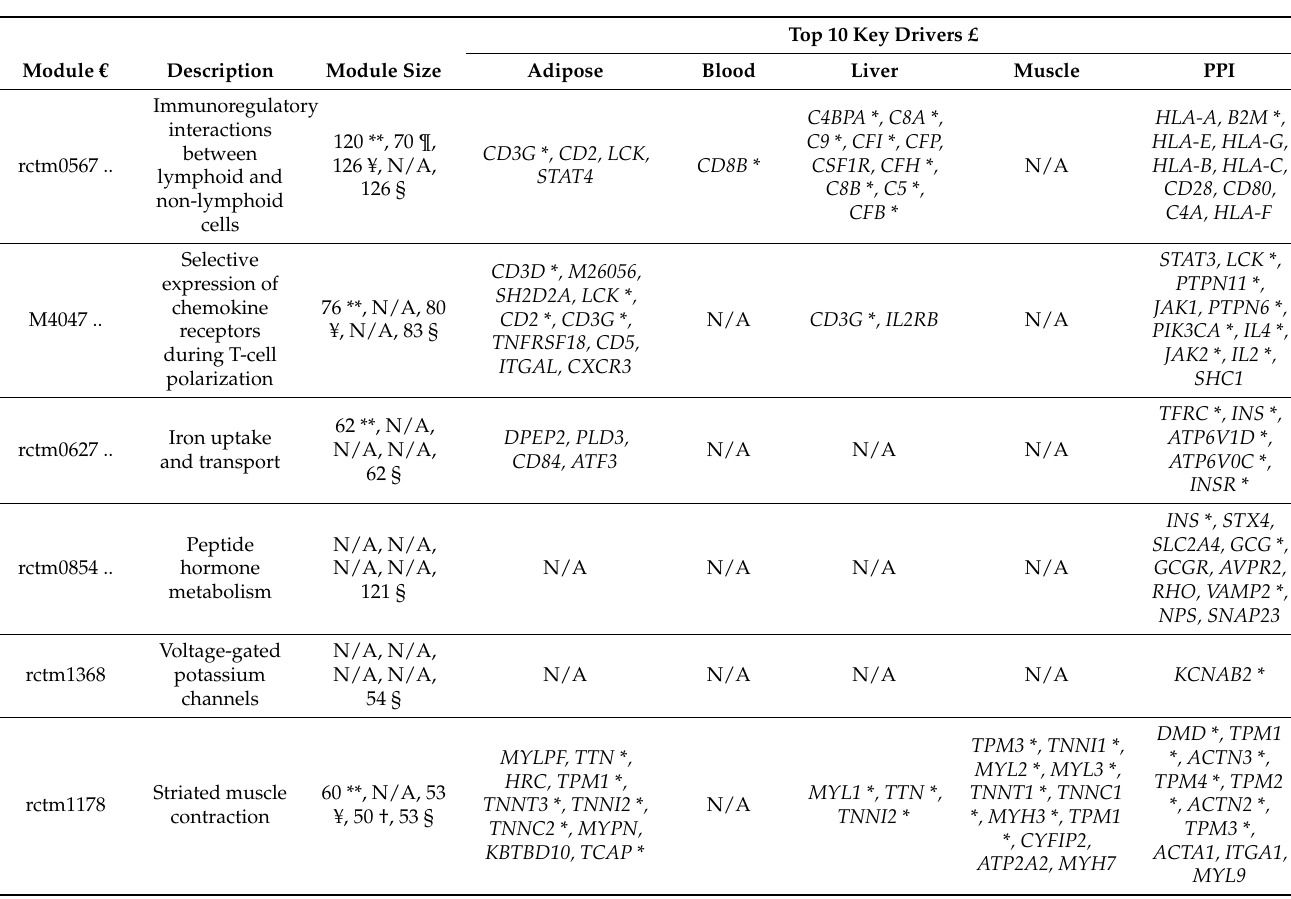
Table 1. MSEA Meta-analysis of CRP and IL6 pathways (distance-based mapping) and corresponding tissue specific– network key